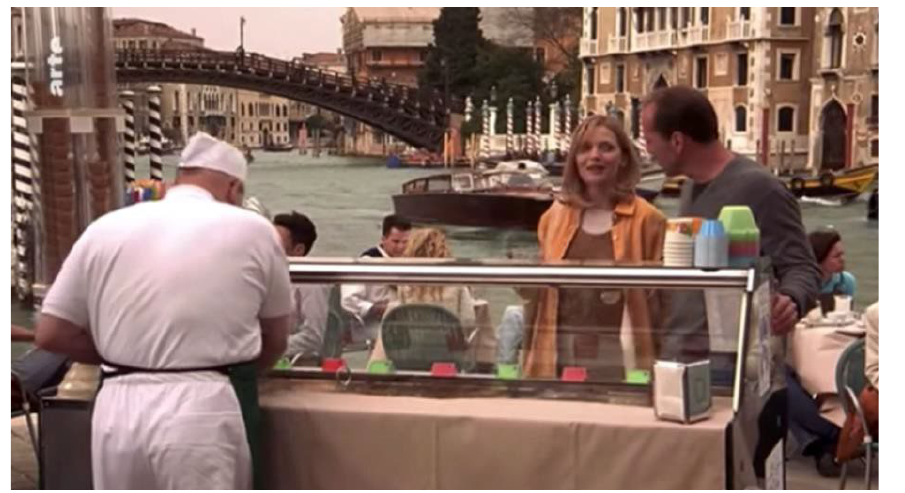
Figure 3 Bruce Willis and Michelle Pfeiffer on the Canal Grande in The Story of Us (Reiner, USA,